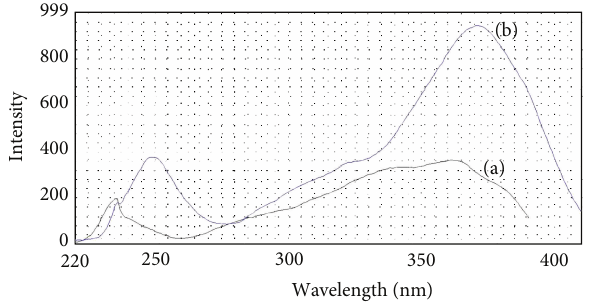
Figure 3: Comparison of excitation spectra. (a) The product of OPA reacting with ammonium; (b) the product of MOPA reacting with